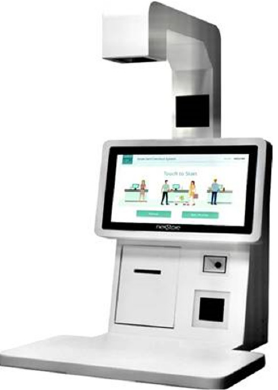
Figure 1. Self ‐ checkout platform. Figure 1. Self-checkout platform.